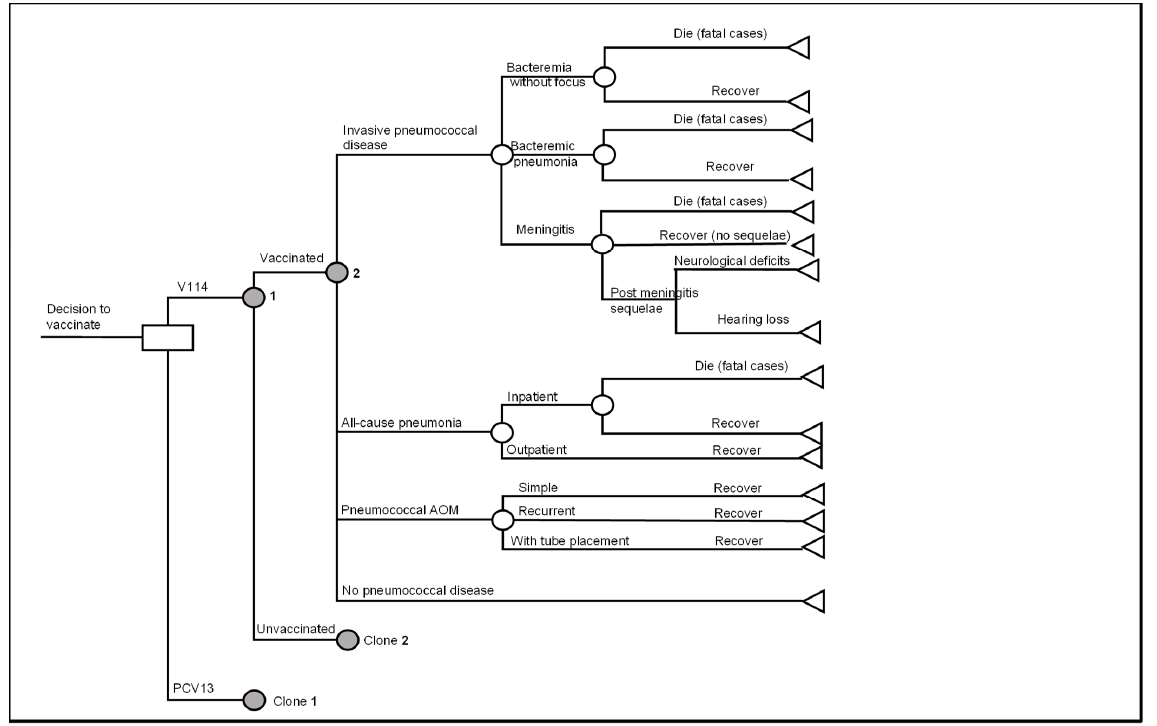
Figure 1. Decision analytic model of pediatric pneumococcal vaccination. Abbreviations: PCV13 = 13-valent pneumococcal conjugate vaccine; V114 = 15-valent pneumococcal conjugate vaccine; AOM = acute otitis media. Notes: (1) The clone nodes are identical in structure to the original nodes but can have different probabilities of events. (2) general background mortality applies to all health